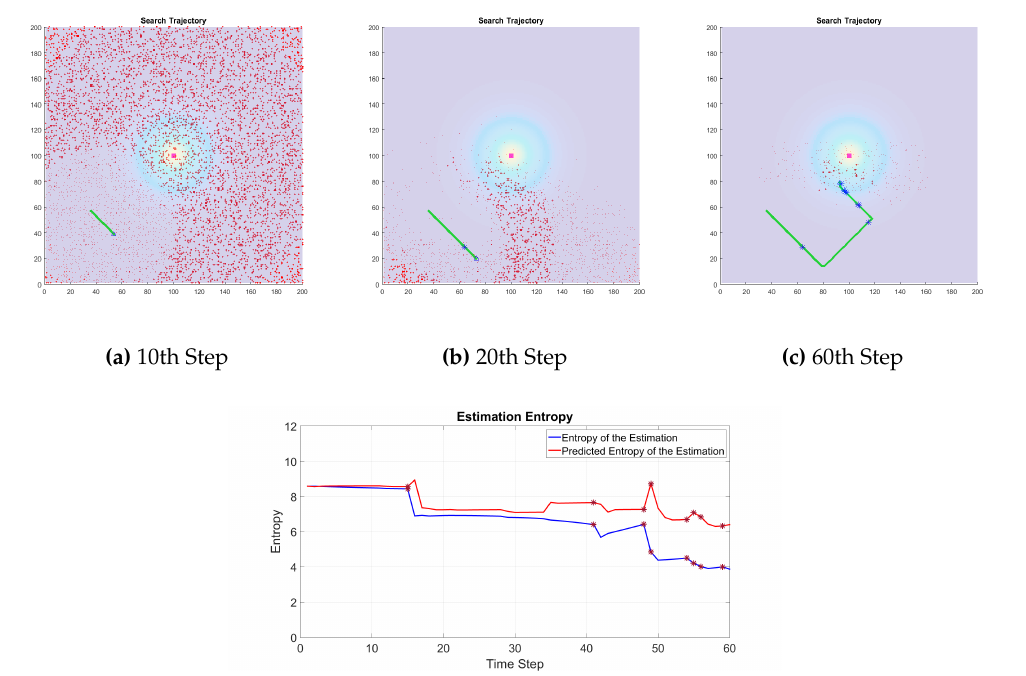
Figure 3. ( a – c ) Search trajectory for a single robot searching for a source of chemical dispersion. ( d ) Variation of the entropy for the estimated probability distribution. The probability of detecting a chemical cue is proportional to the bearing of the robot with respect to the sources position. The chance of detecting a cue increases when the robot is moving toward the source. Red plot indicates the change in entropy the robot predicts upon the move, while the blue plot is the entropy of the estimation calculated after performing the observation. About 10,000 particles are initially generated to estimate the probability distribution. Size of the particles does not represent the associated weight of the particle.